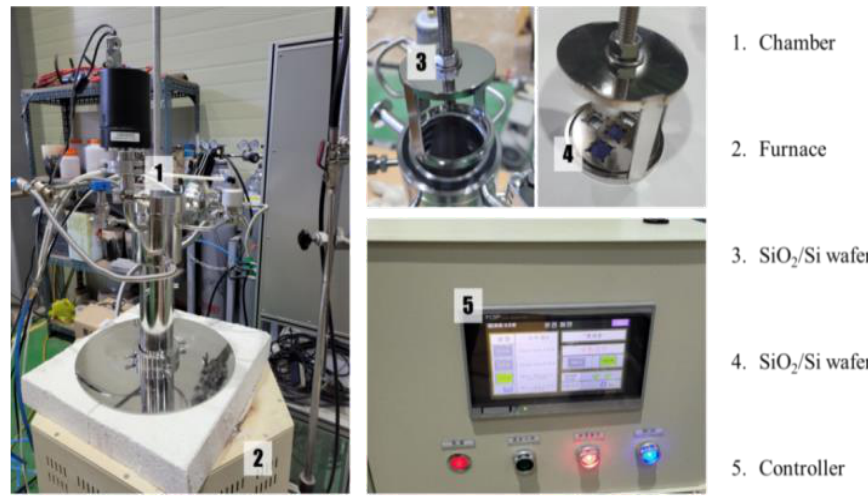
Figure 1. Apparatus for the experiment on carbon sources